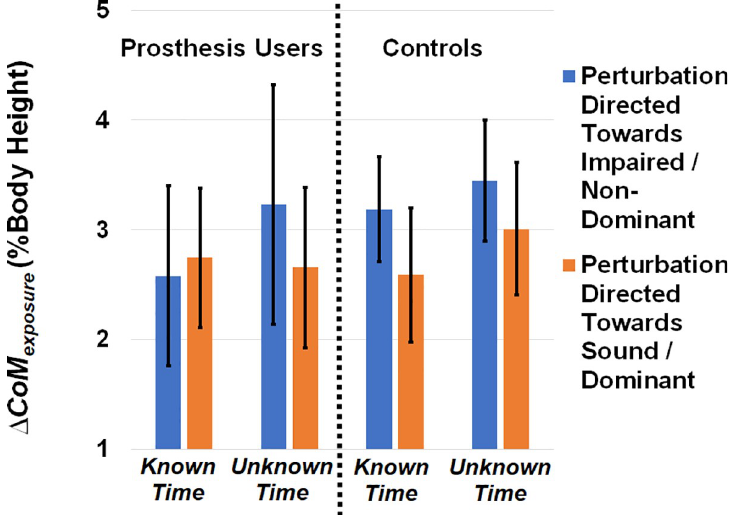
Fig 3. Average CoM displacement during the 400 msec exposure period ( Δ CoM perturbation direction, and perturbation timing knowledge. The main effect of perturbation direction was significant (p = 0.033) with displacement greater with perturbations towards the impaired/non-dominant side. Error bars denote 95% confidence